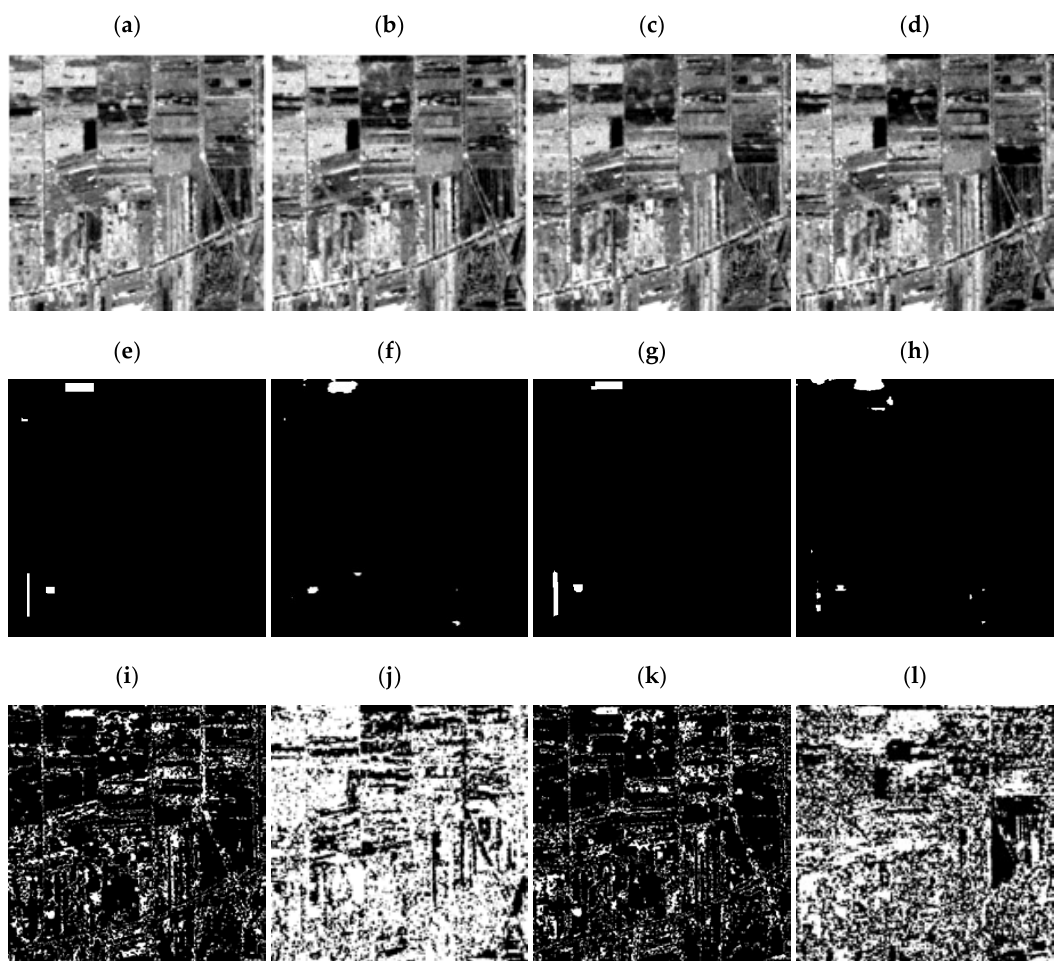
Figure 9. Results of the Bangkok site in the first area. The resolution of each image is 6 km × 6 km (for SAR pairs 27 November 2008/15 January 2010 and 12 January 2009/21 November 2009, respectively: ( a , c ) Time 1 SAR image, ( b , d ) Time 2 SAR image, ( e , g ) ground truth, ( f , h ) proposed result, ( i , k ) result of fuzzy c-means (FCM), ( j , l ) result of Otsu).